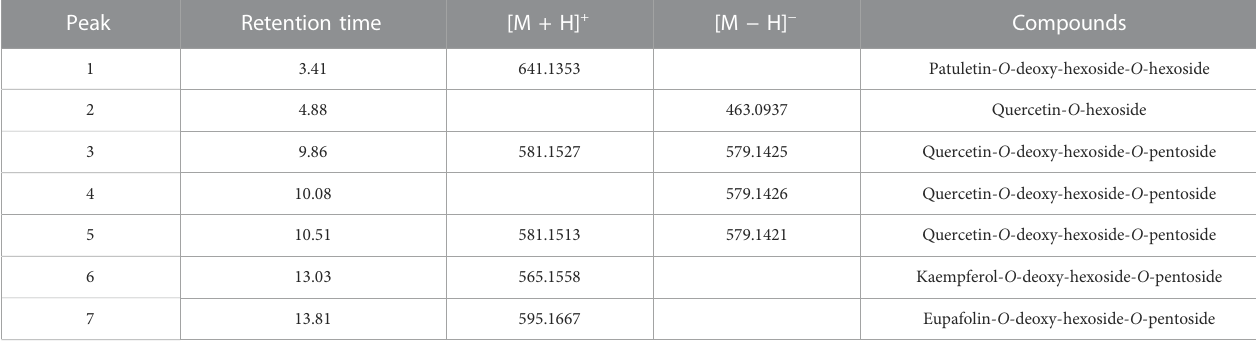
TABLE 2 Compounds characterized through UHPLC-MS in B. pinnatum free leaf extract.